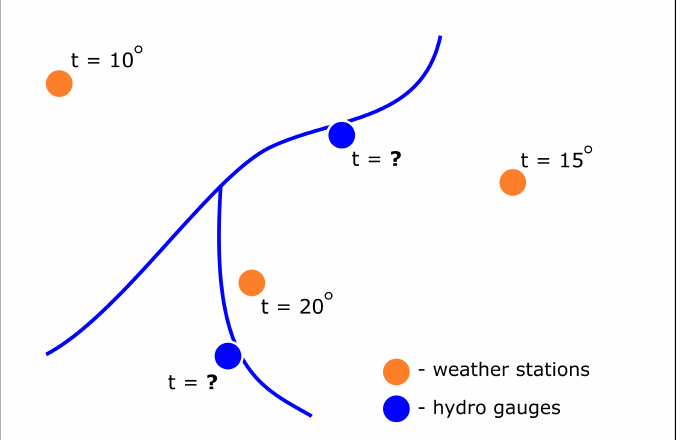
Figure 4. The task of the meteorological parameters values interpolation to the level gauges. The example of mean daily air temperature is presented. Sign “?” means that the value of the parameter in the station is